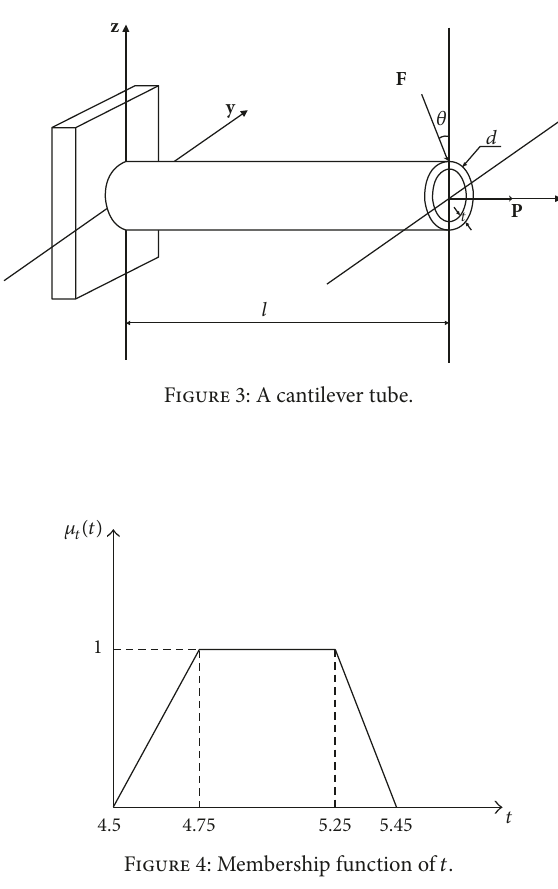
Figure 4: Membership function of 𝑡